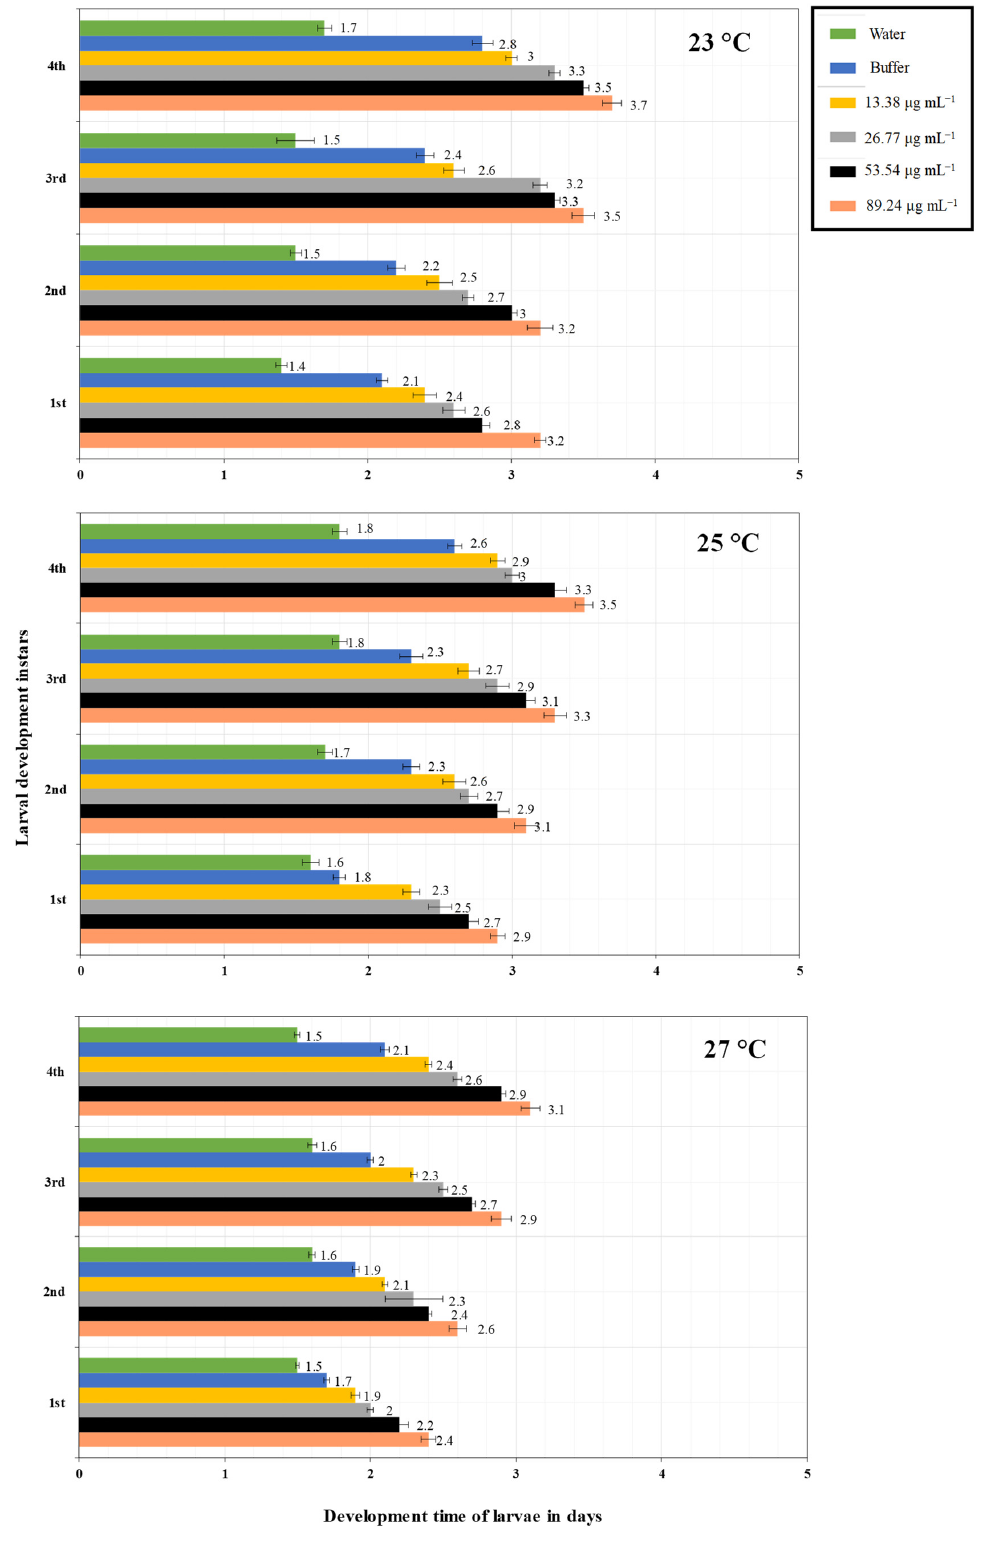
Figure 3. On O. sativa plants, the PeVL1 elicitor protein elicited the development of M. ruralis larval instars at various doses and temperatures (23, 25, 27 °C) ( n = 10; one-way ANOVA with factorial analysis; LSD at α = 0.05).